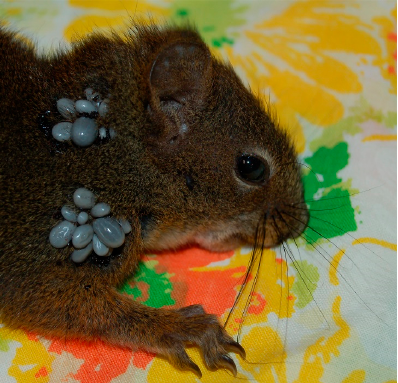
Figure 3. Red squirrel parasitized by 29 I. angustus females. Five males were copulating on the ventral surface of five females, and are not visible. Some of the I. angustus ticks on this host were positive for B. burgdorferi sensu lato. Photo credit: Christina Carrieres.